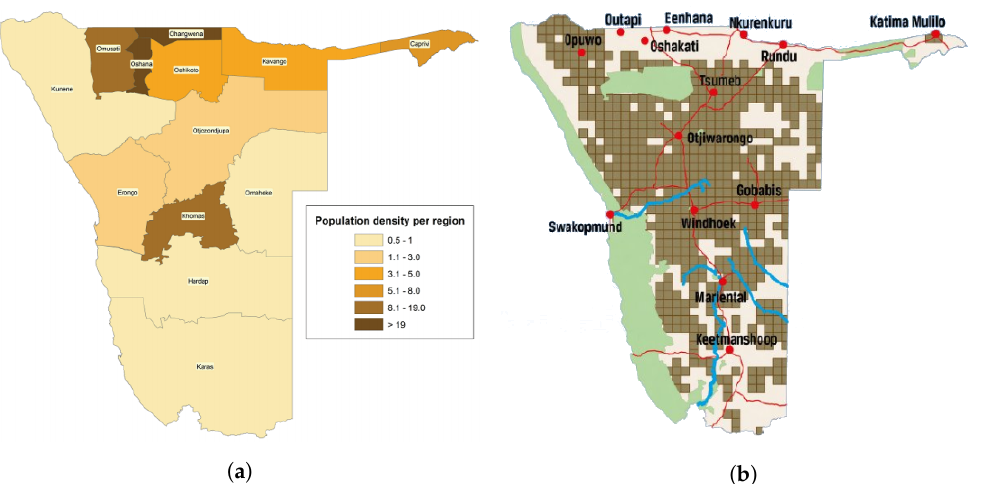
Figure 2. Namibian population distribution, with dark areas indicating high population density and light areas indicating low population densities [21] ( a ), versus encroacher bush distribution, with brown areas indicating encroacher bush occurrence [22] ( b ). Green represents areas of encroacher bush